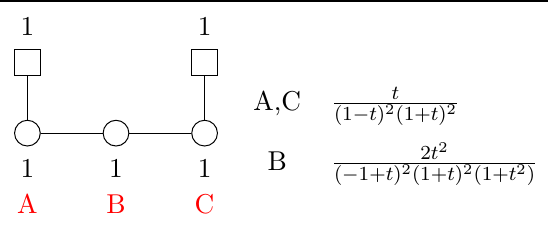
Table 5. Sp(1) with N f = 3 . B-twisted index with Wilson lines added at the labelled position in the